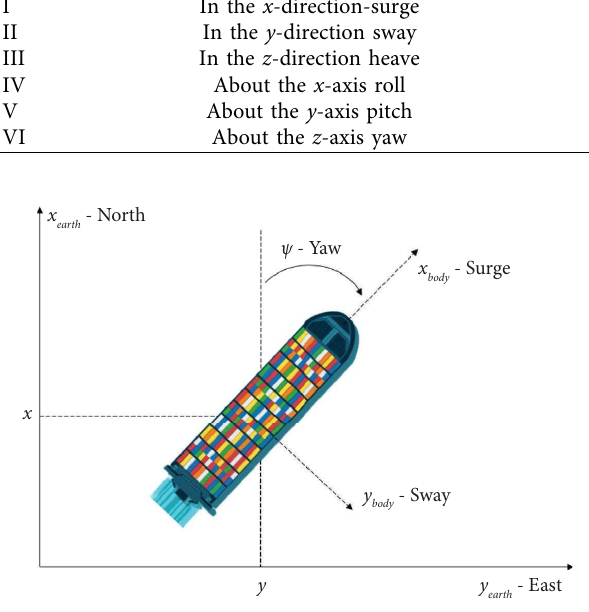
Figure 3: Earth and body frame with heading and